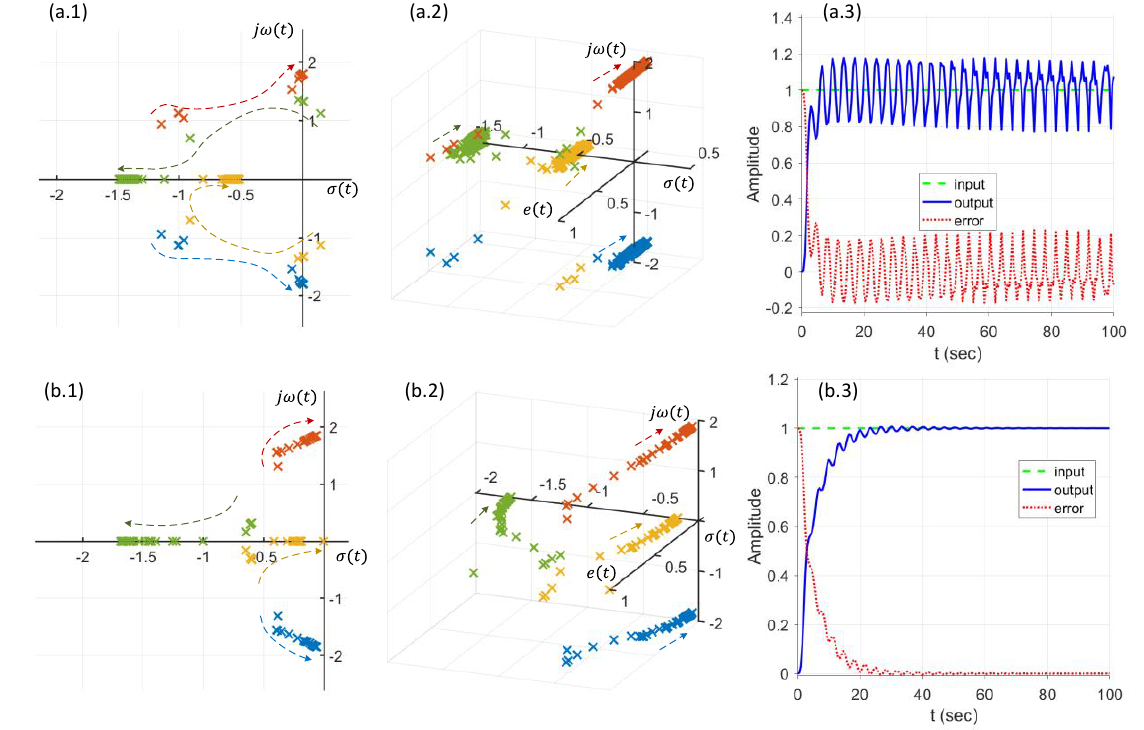
Figure 9. Dynamic pole motions of the controlled hybrid soft leg and the controlled system response by error change with the gains of ( a ) 𝐾 𝑝𝑓 = 1.5 , 𝐾 𝑣𝑓 = 3.5 , 𝛼 = 1 , and 𝛽 = 2 , and ( b ) 𝐾 𝑝𝑓 = 0.1 , 𝐾 𝑣𝑓 = 3.5 , 𝛼 = 1 , and 𝛽 = 2 . The arrows indicate the direction of pole motions. We further examined the effect of 𝐾 𝑣𝑓 on the controlled system response (i.e., only 𝐾 𝑣𝑓 was changed, keeping other gains with the initial values), and the results are exhib-